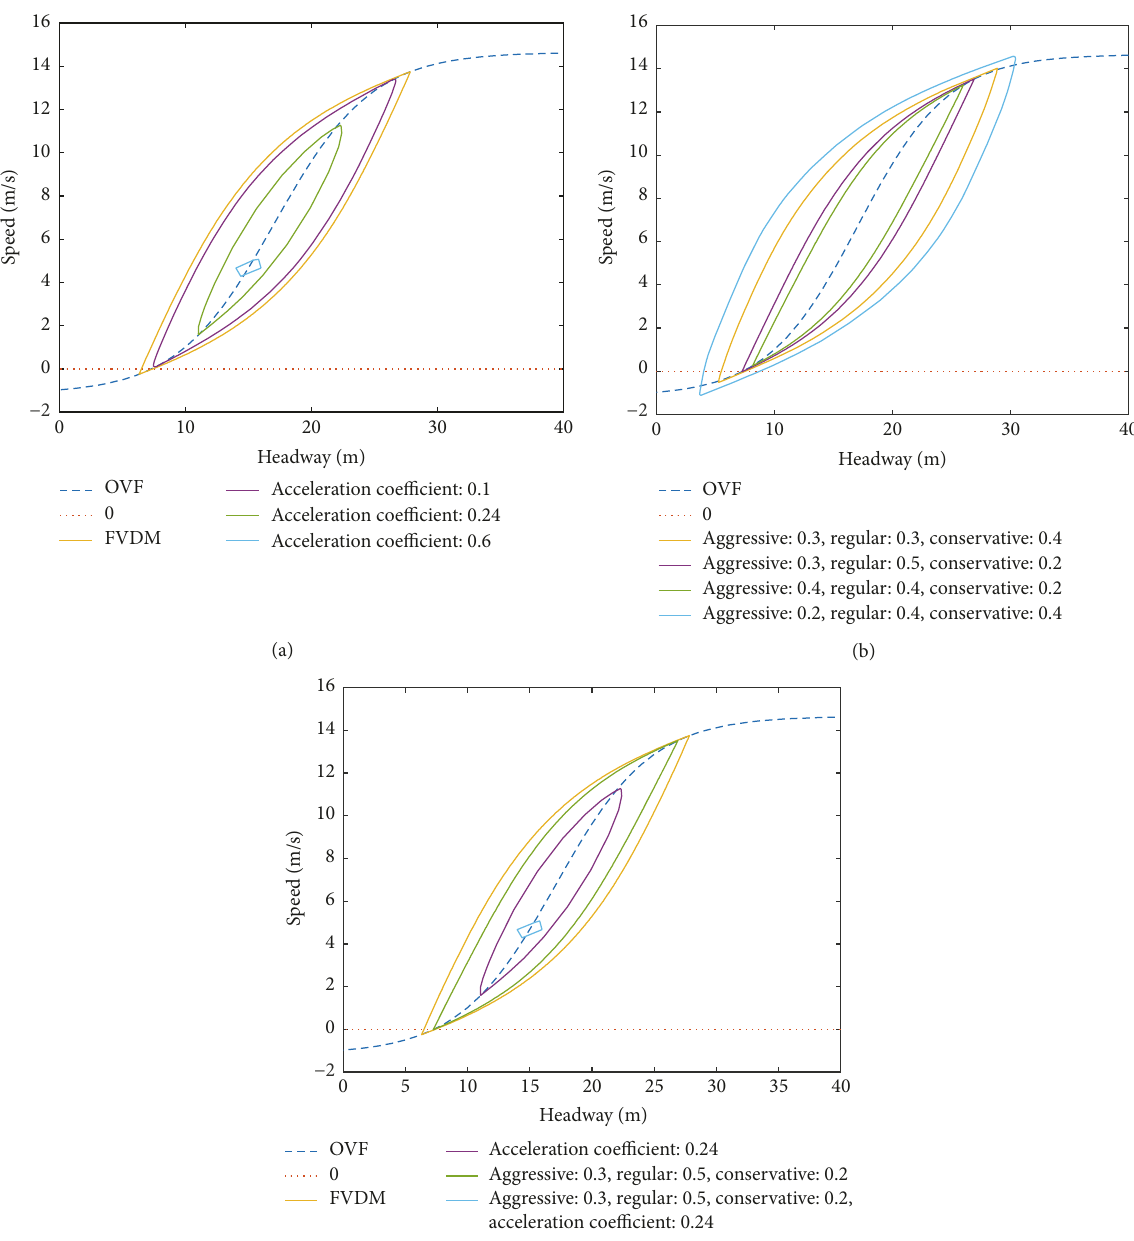
Figure 11: The loops for (a) a model considering the acceleration of leading vehicle and (b) a model considering driving characteristics and (c) the proposed model ( 𝜆 = 0.45 , 𝑝 1 = 0.3 , 𝑝 2 = 0.1 , and 𝑝 3 = −0.3 ). OVF is short for optimal velocity function and FVDM is short for full velocity difference